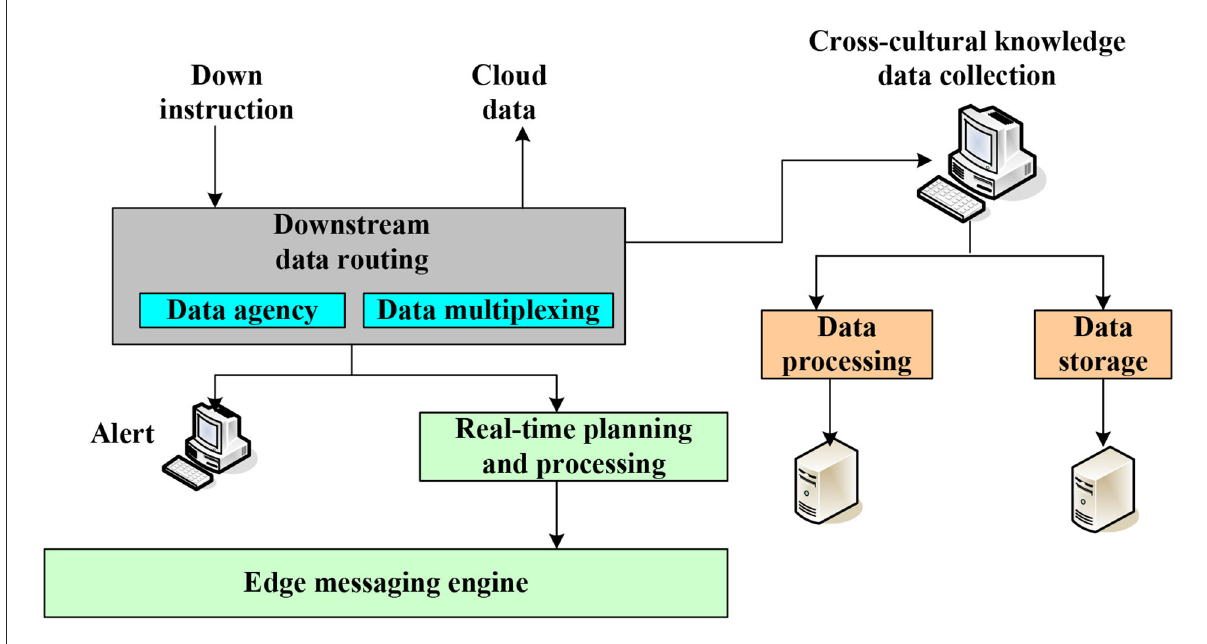
FIGURE2 Wisdom teaching of cross-cultural